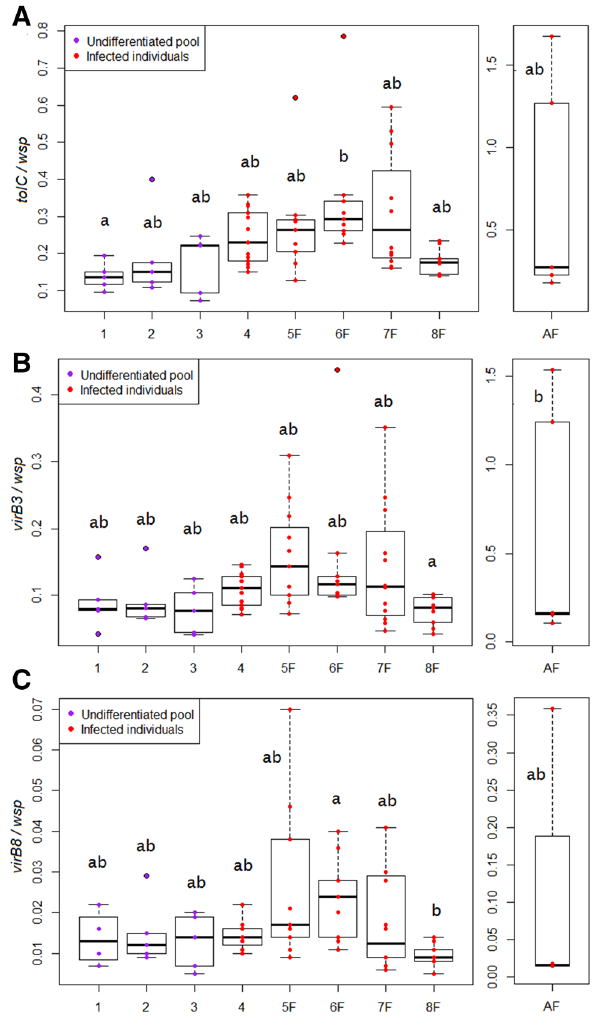
Figure 3. RT-qPCR expression profiles of the T1SS and T4SS genes during development in the Wolbachia - infected lineage of A. vulgare . The expression level of the tolC ( A ), virB3 ( B ) and virB8 ( C ) genes were normalised to the one of the wsp transcripts. Pools of undifferentiated larvae were sampled after birth (stage 1), one and two weeks after birth (stages 2 and 3, respectively). For the next developmental steps, Wolbachia - infected animals were sampled individually: undifferentiated juveniles (stage 4), and phenotypic females (stages 5–8) until adulthood (AF for adult